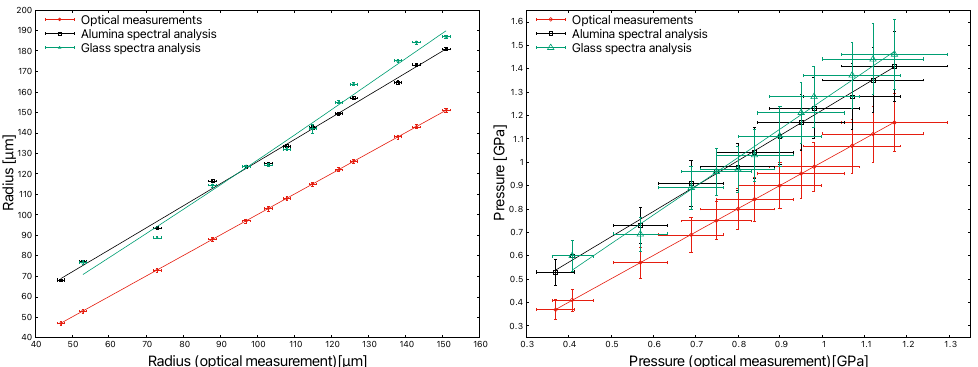
Figure 8. Comparison of the contact’s radius measurements ( left ) and the maximum pressure measurements ( right ) depending on the method used.